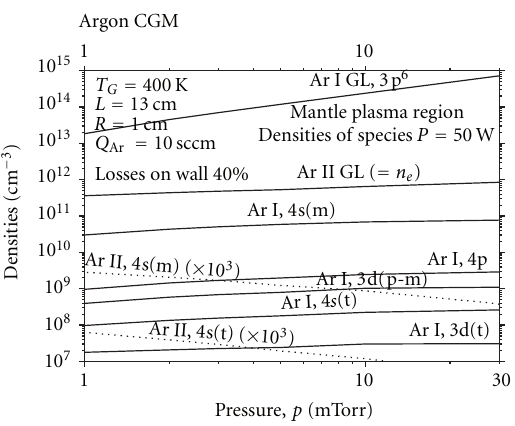
Figure 13: Calculated densities of Ar GL , Ar excited species, and Ar + in the mantle plasma region; (m) = metastable, (t) = transitory, (p- m) = pseudometastable.